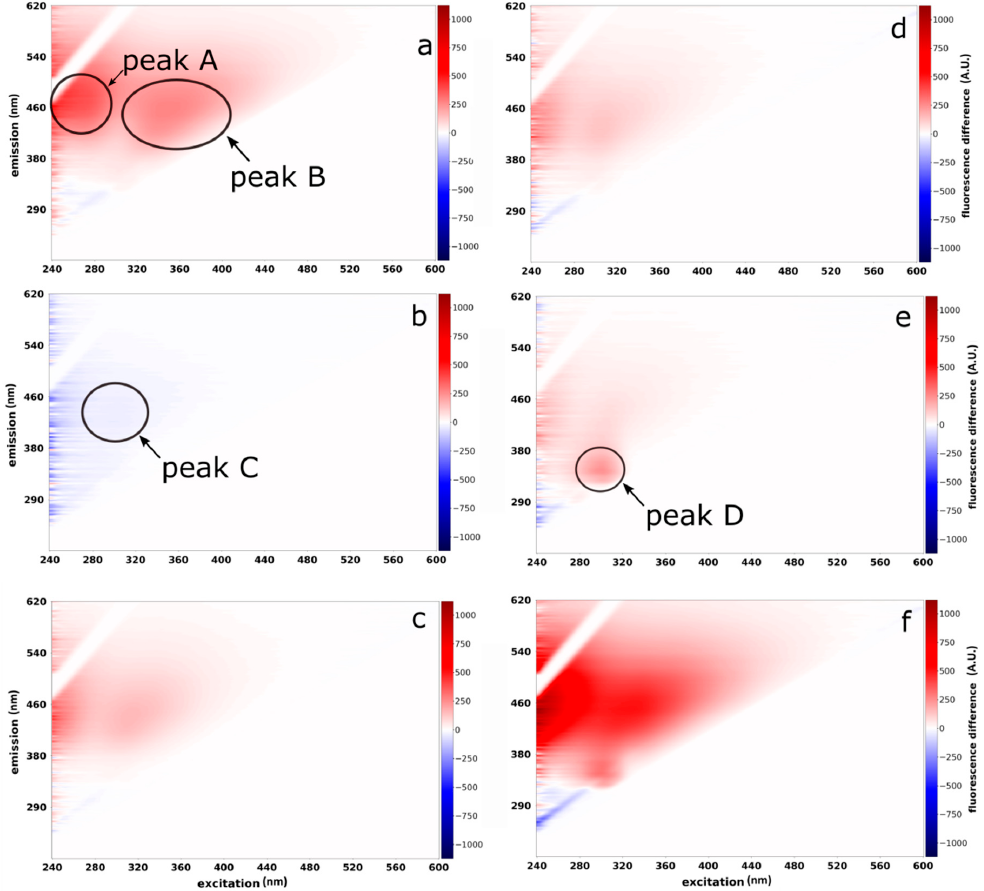
Figure 3. Fluorescence difference spectra of the median of the different samples and a filter level of 0.2 µm. In ( a ) the difference of the first day and ( b ) the difference overnight of the first and the